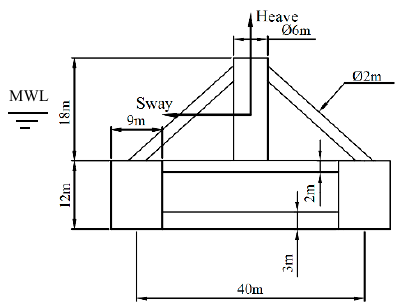
Figure 2. Coordinate system and main dimensions of the SFOWT platform. Table 1. NREL-5MW wind turbine principal properties. Table 2. Floating platform principal